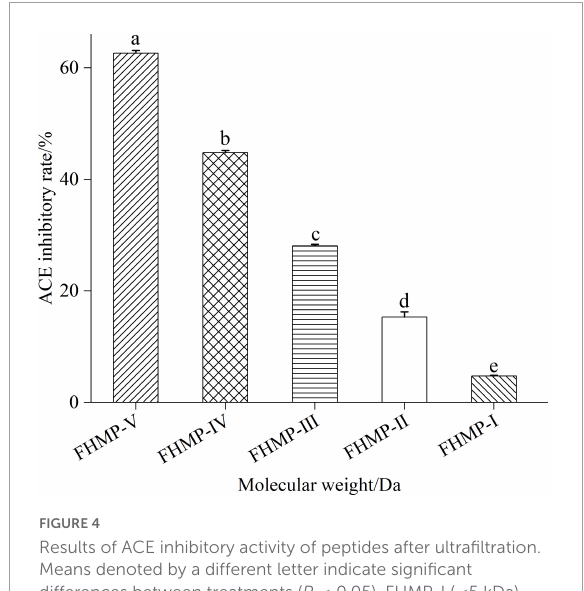
TABLE 5 Peptide sequences with fractions higher than 80 in FHMP-V-3 were identified by LC-MS/MS combined with de novo sequencing.